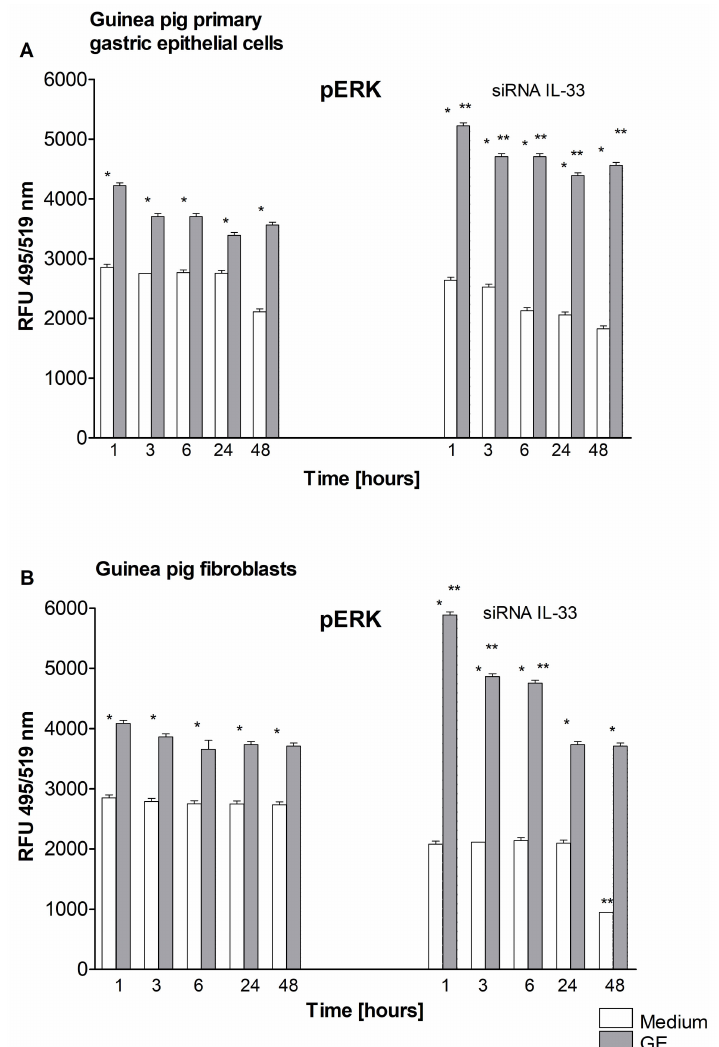
Figure 4. Activation / phosphorylation of Erk. Level of phosphorylated Erk (pERK) detected at time points: 1, 3, 6, 24, 48 h in cell cultures of guinea pig primary gastric epithelial cells ( A ) or fibroblasts ( B ), not transfected or transfected with siRNA IL-33, in medium only or exposed to H. pylori glycine acid extract. (GE). Activation of Erk was estimated based on relative fluorescence units (RFU) of cells intracellularly stained for pErk. Fluorescence was measured in a fluorescence reader (Victor 2, Wallac, Oy Turku, Finland) at wavelength: 495 excitation and 519 emission (emission). The results of four independent experiments performed in triplicates for each experimental variant are presented. Statistical analysis was performed using the nonparametric U Mann-Whitney test with significance for *, ** p < 0.05, * unstimulated (only medium) vs. GE stimulated untransfected or transfected cells, ** untransfected vs. transfected cells in medium only or in medium with